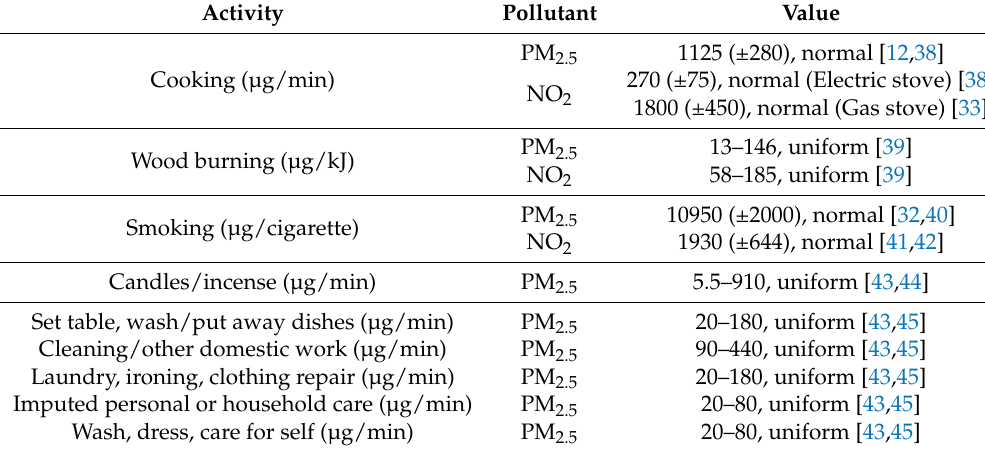
Table 3. Values of source